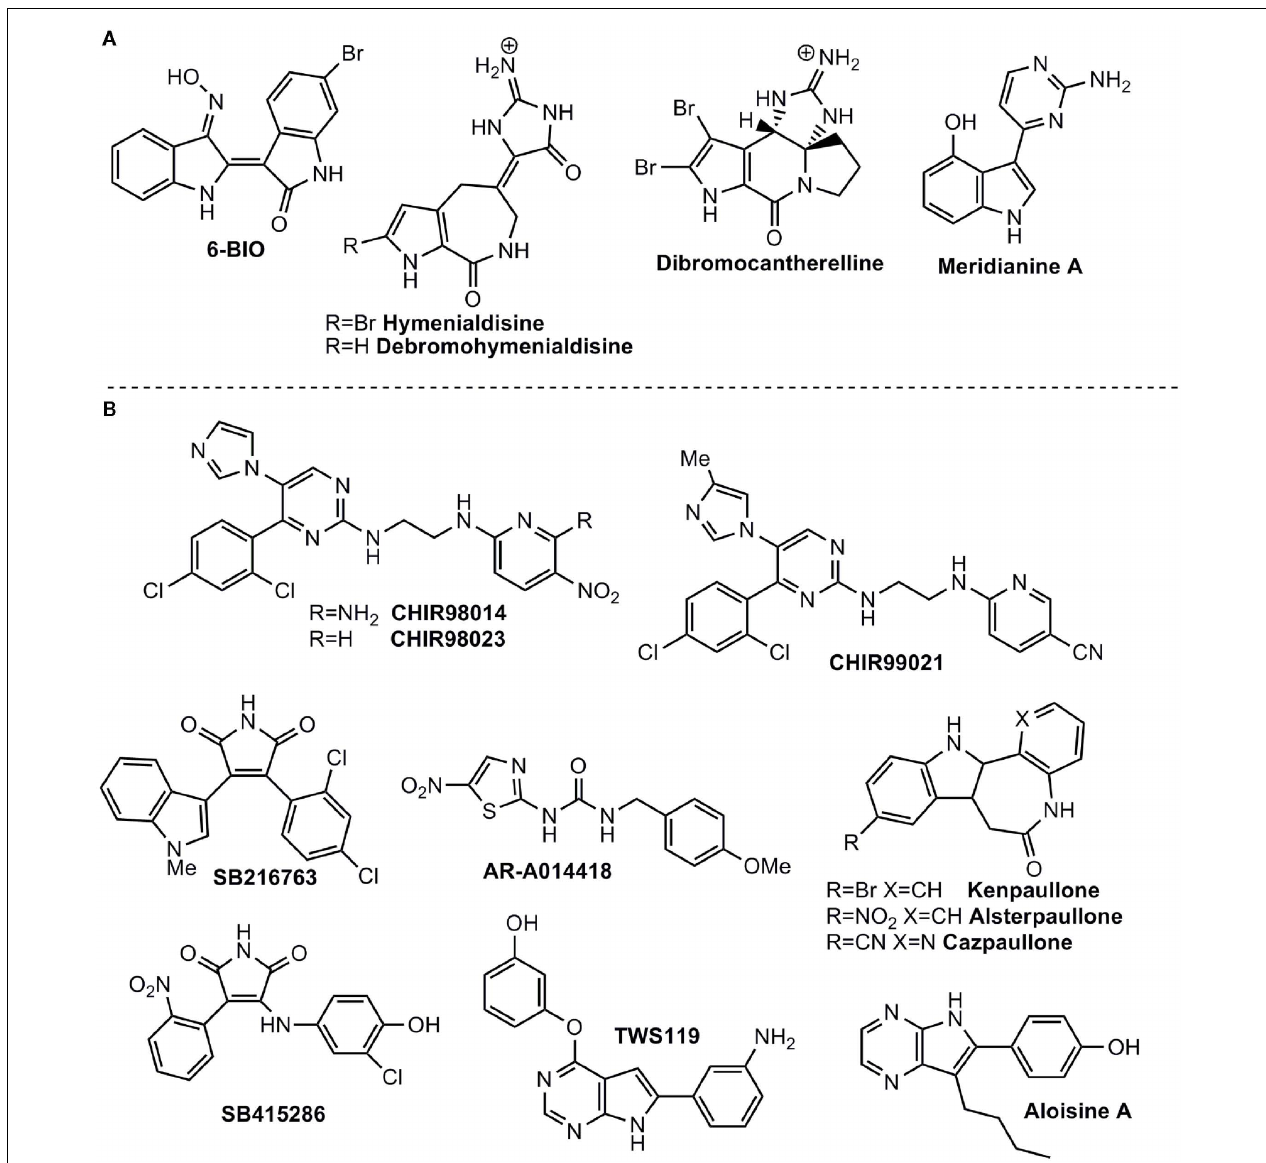
FIGURE 1 | SomeATP-competitive GSK-3 inhibitors with potential for CNS disorders. (A) Isolated from marine organisms. (B) Small molecules from organic synthesis programs.